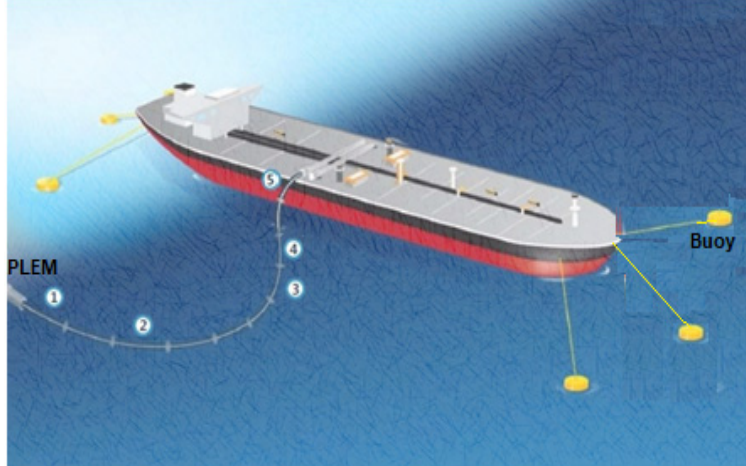
Figure 18. Tandem mooring reel catenary hose configuration.